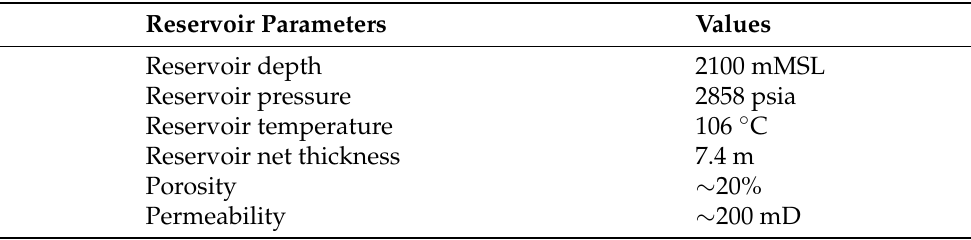
Table A2. Summary of the reservoir properties and operational conditions of our single well CO 2 injection test reported in